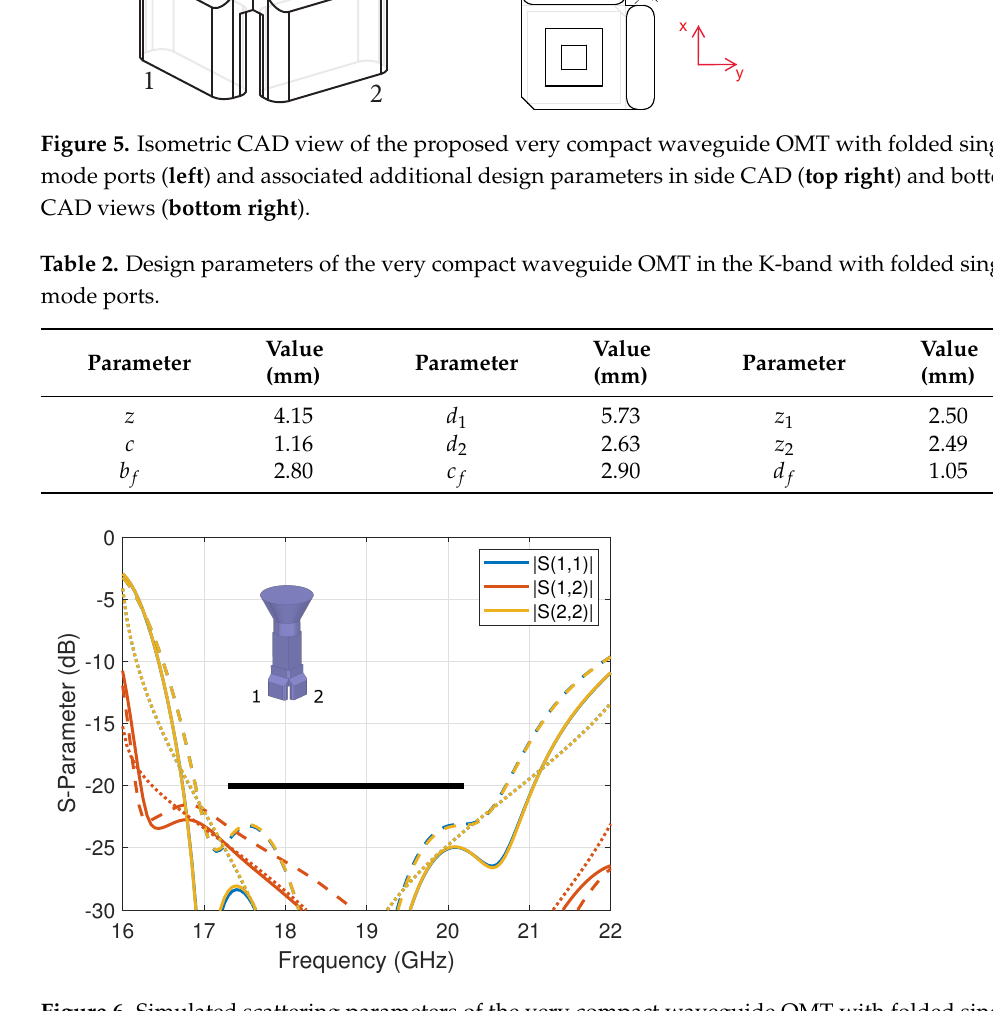
Figure 6. Simulated scattering parameters of the very compact waveguide OMT with folded single- mode ports assembled with a conical horn ( solid lines ) compared to the reference OMT design with straight single-mode ports ( dashed lines ). The simulated standalone OMT results are overlaid in dotted lines . The specifications are marked with a black thick line